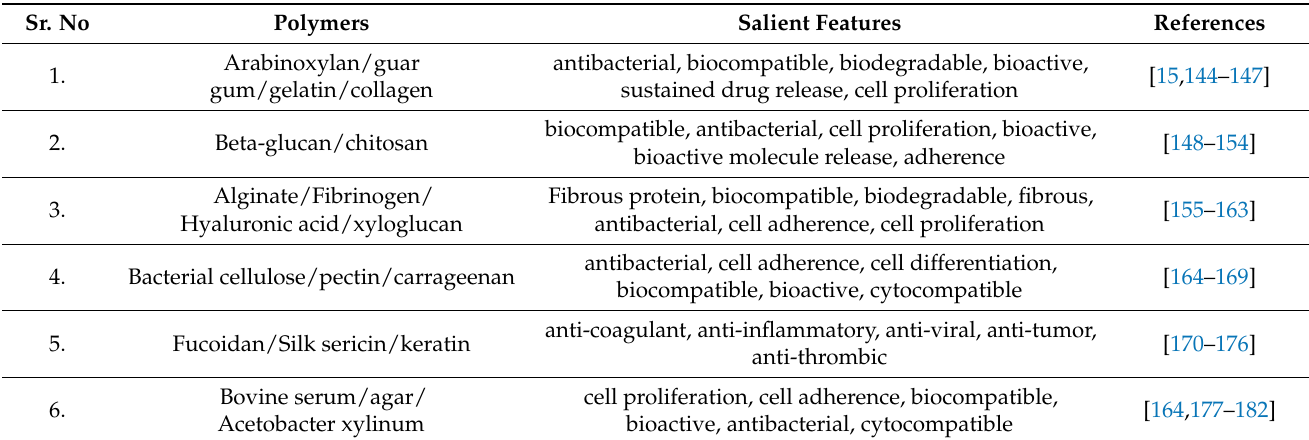
Table 2. Biopolymeric materials as a potential biomaterial in wound